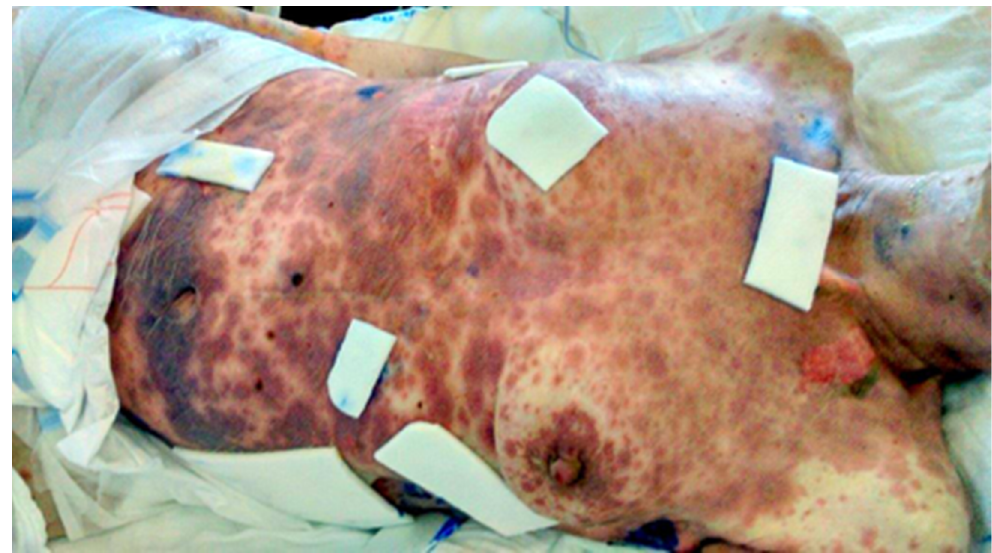
Figure 1. Haemorrhagic vesiculobullous lesions on facial skin and